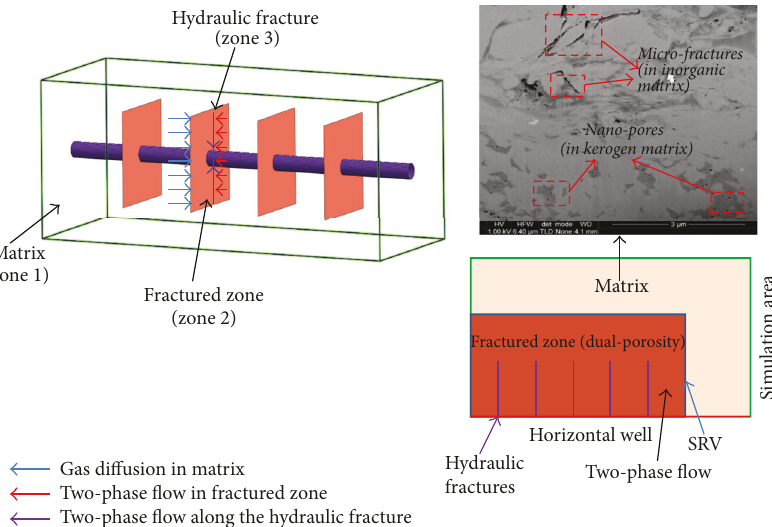
Figure 1: Snapshot of shale gas recovery in typical three zones (SEM from [23]).